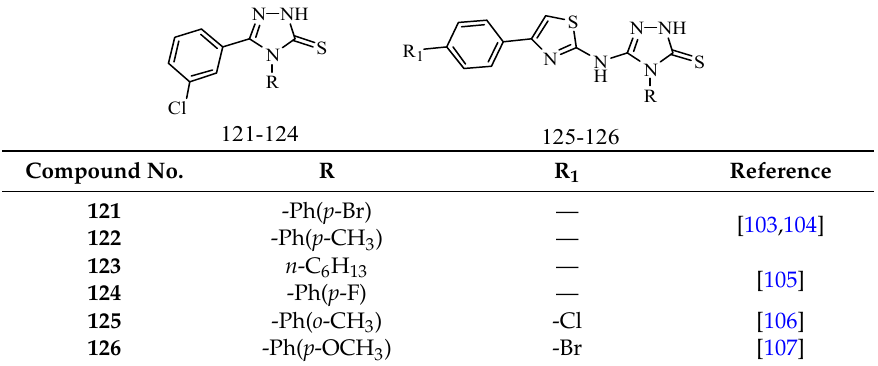
Table 6. Structures of compounds 121 – 126 .